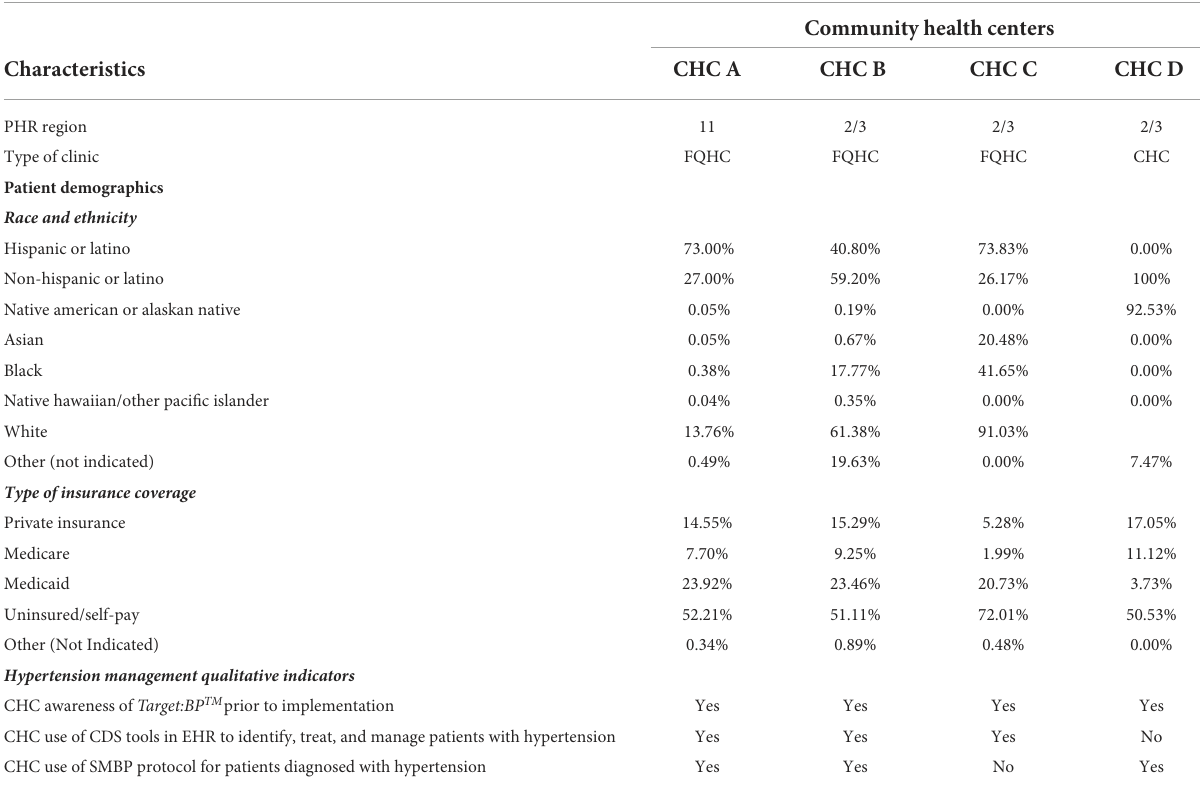
TABLE 2 Results from community health centers needs assessment survey.